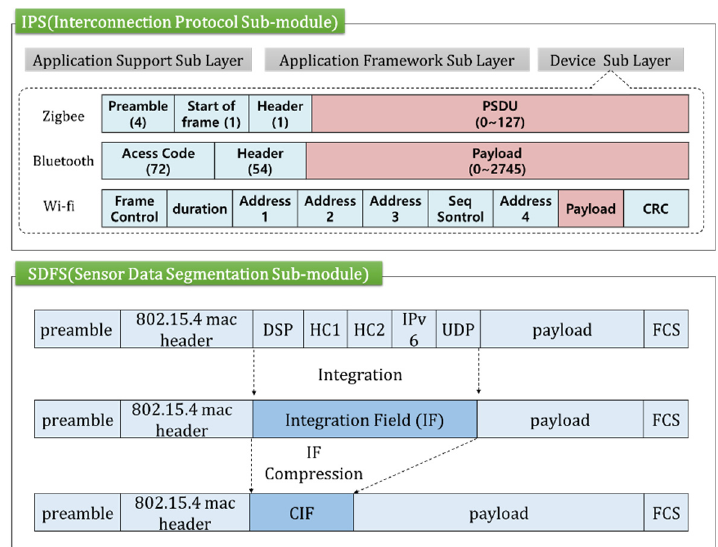
Figure 4. Structure of the interconnection protocol sub-module (IPS). PSDU: physical service data unit;